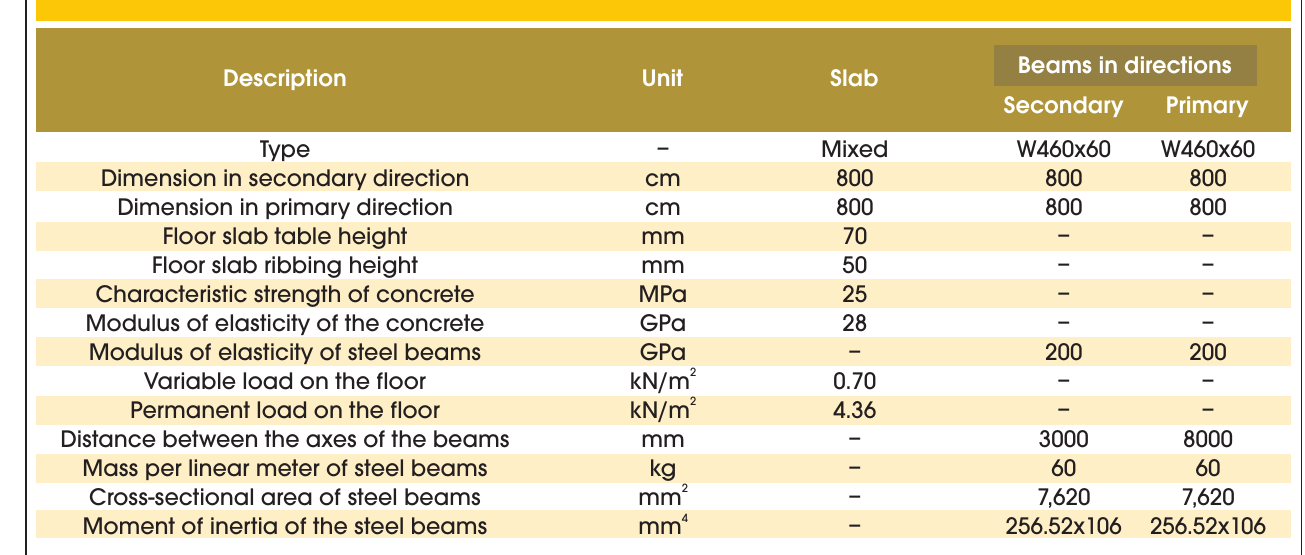
Table 5.5 – Input data of the numerical